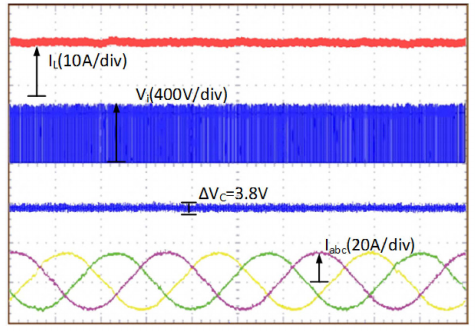
Figure 17. Experimental waveforms in the improved PWM scheme.